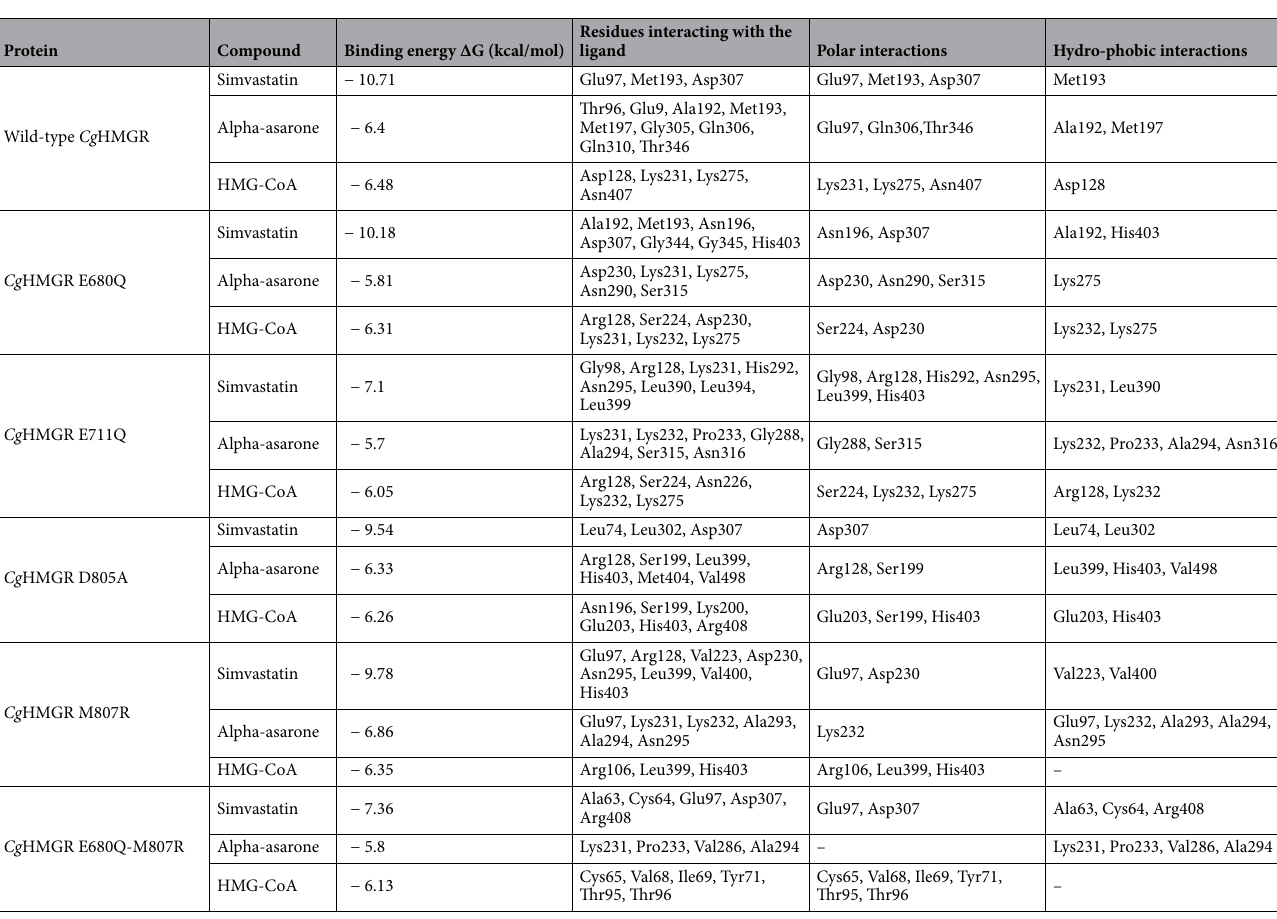
Table 1. Results of docking simvastatin, alpha asarone, and HMG-CoA at the active site of HMGR of Candida glabrata ( Cg